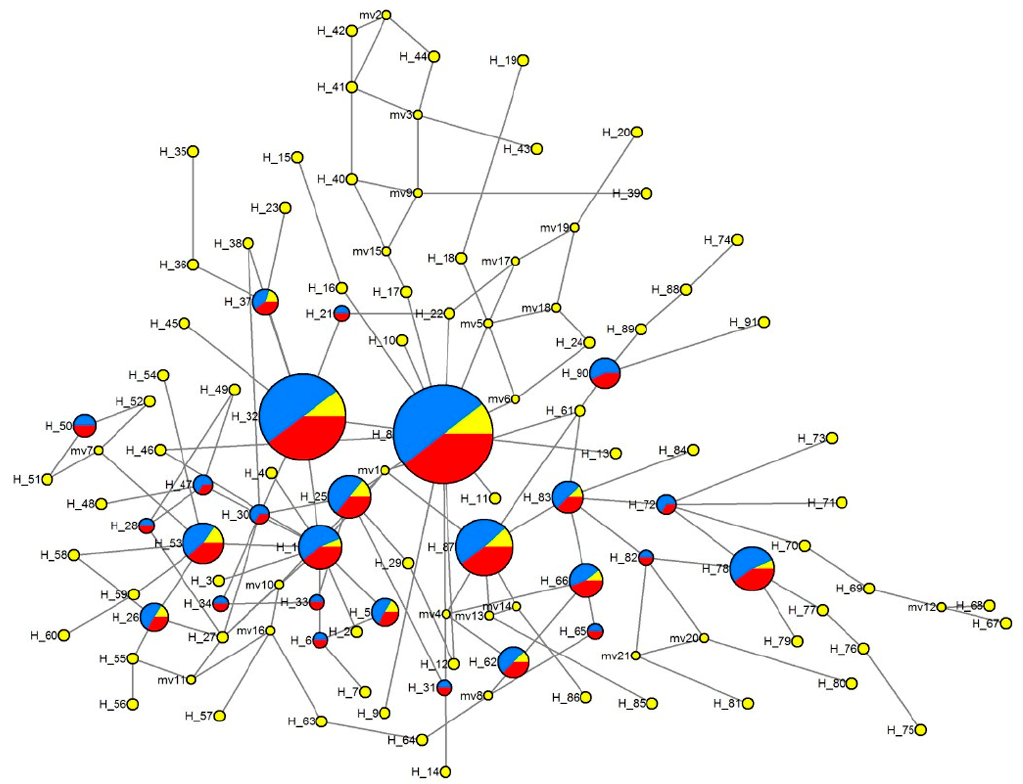
Figure 3. Median-joining network of haplotypes. Blue, Western China; red, Central China; yellow, Southern China.